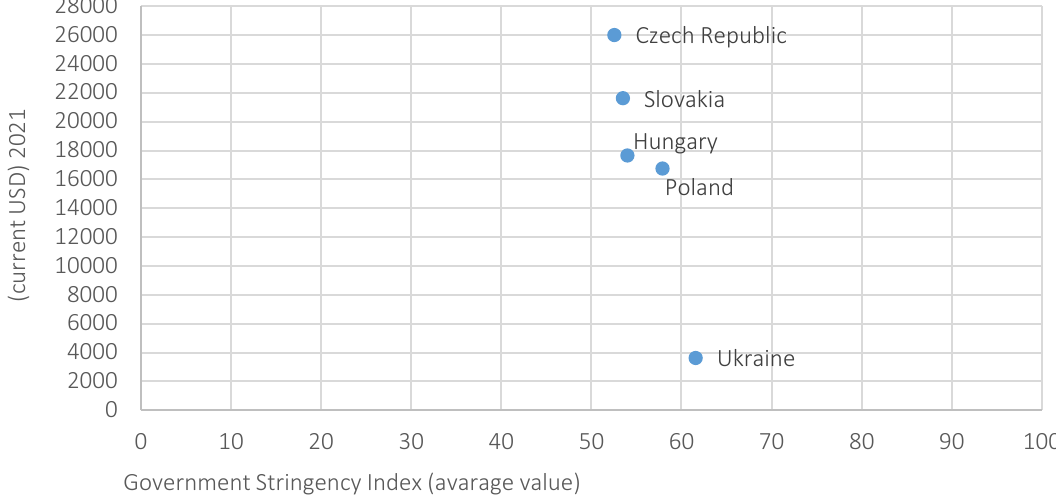
Figure 1. GDP and GSI of Ukraine, Poland, Czech Republic, Hungary, and